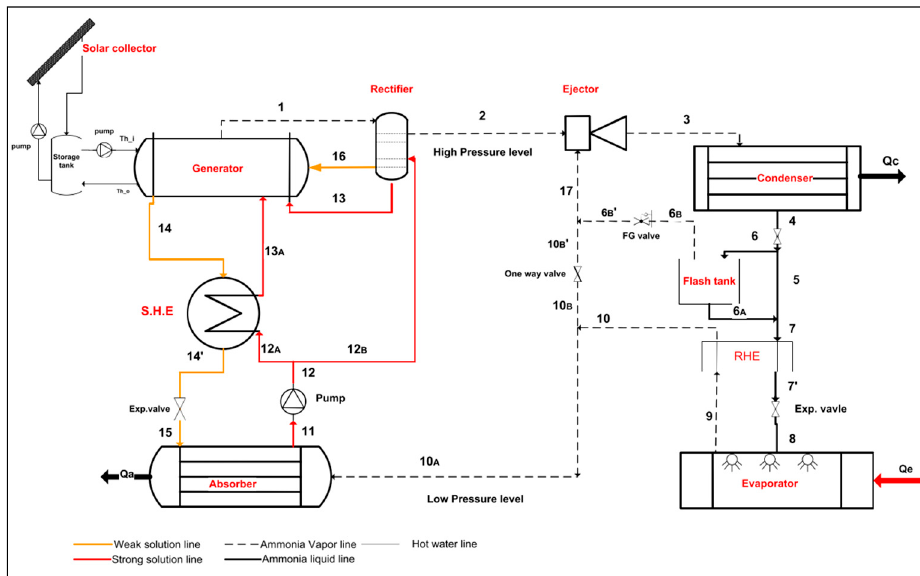
Figure 33. NH 3 /H 2 O ejector-absorption heat pump [327].